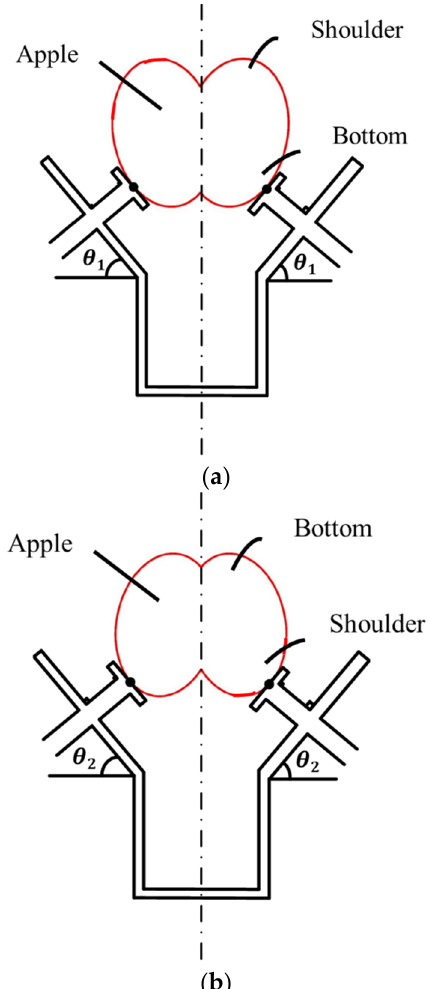
Figure 19. Three suction cup layout designs: ( a ) suction cup layout structure for the bottom; ( b ) suction cup layout structure for the shoulder, where 1: mechanical hand; 2: mounting holes. According to Section 2.2, we can get the curvature range of the apple shoulder as (2.603, 12.382) and the curvature range of the bottom as ( − 3.189, − 3.007), as shown in (cid:95) A 11 A 1 A 12 at A 1 , the tangent